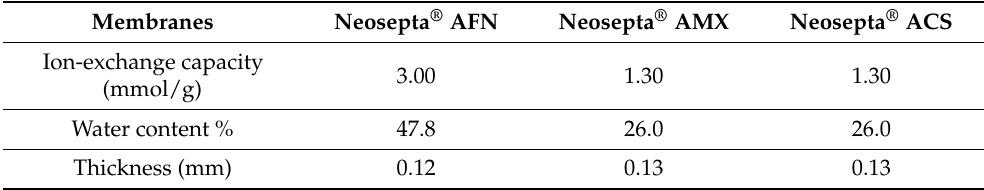
Table 4. Properties of three anion-exchange